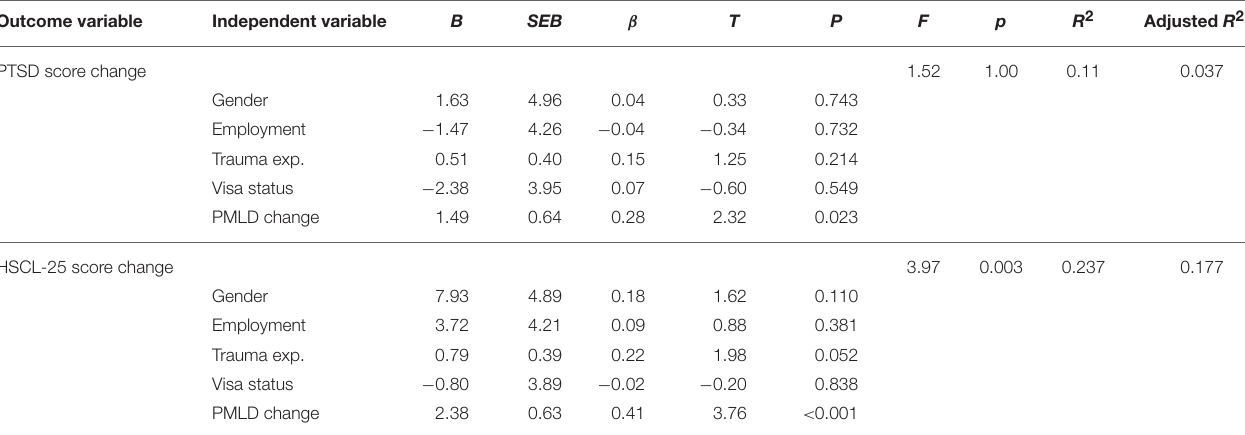
TABLE 4 | Summary of the multiple regression analyses ( N = 71). Outcome